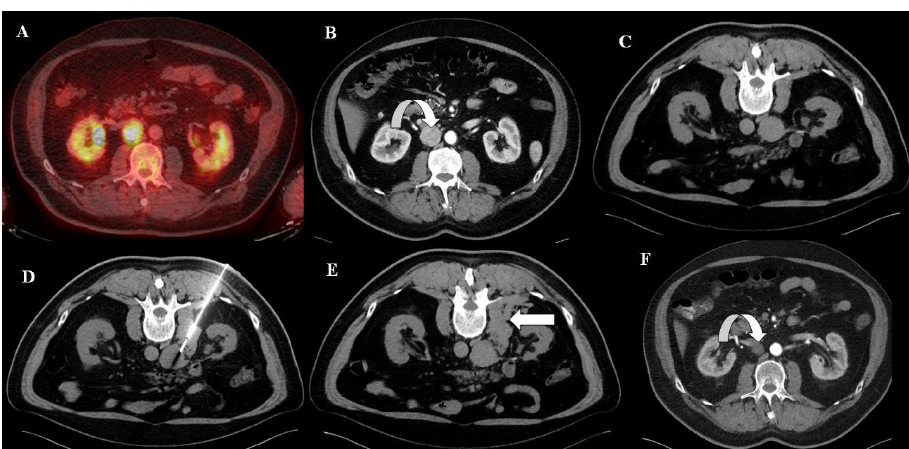
Fig. 2. The hemorrhage. Viable mass in retrocaval retroperitoneal space on FDG enhanced PET/ CT (A). The hypervascular mass on contrast medium enhanced CT in the transversal plane and arterial phase (B, curved arrow). Preprocedural CT examination confirms the localization near large vessels, patient in prone position (C). The placement of the biopsy needle (D, patient in prone position), retroperitoneal hemorrhage was present straight after the procedure (E, arrow). The histological result was neuroendocrine carcinoma. Only residual avascular process was revealed by contrast medium enhanced CT examination after 4 months of targeted therapy (F, curved